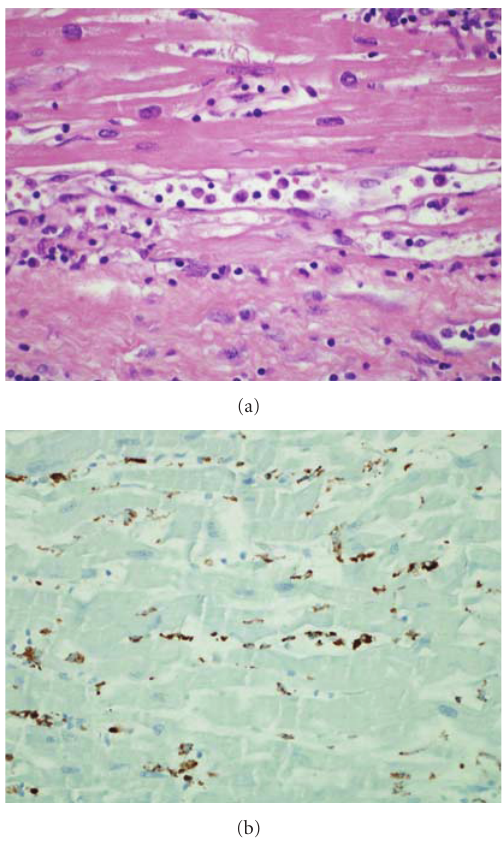
Figure 2: (a) Antibody-mediated rejection, high power. Longitudi- nal section of capillary with mild endothelial cell swelling and ma- crophages accumulating in lumen. (b) Immunoperoxidase staining with CD68 highlights the